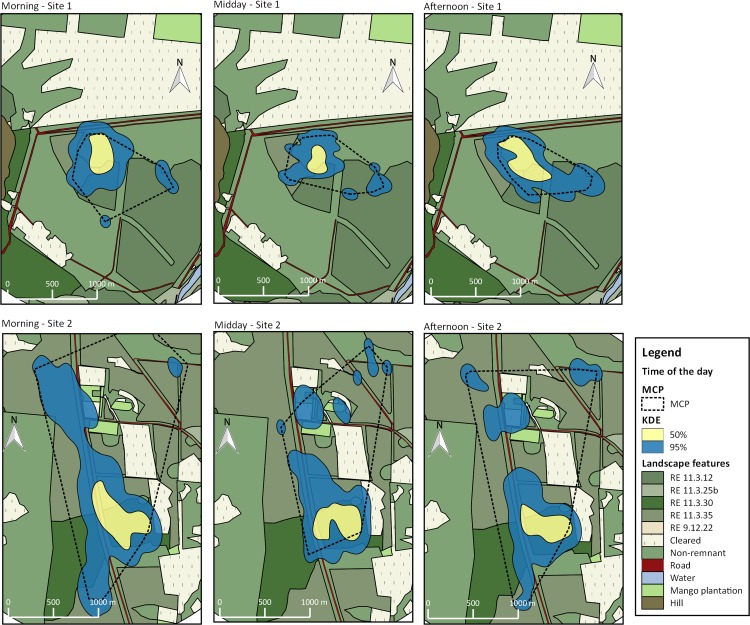
Utilization areas for the flock of BTF Poephila cincta cincta calculated with 95% kde (blue fill), 50% kde (yellow fill) and MCP (dashed line) at Sites 1 (top) and 2 (bottom) for different time of the day (MO = morning, MI = midday and AF = afternoon).